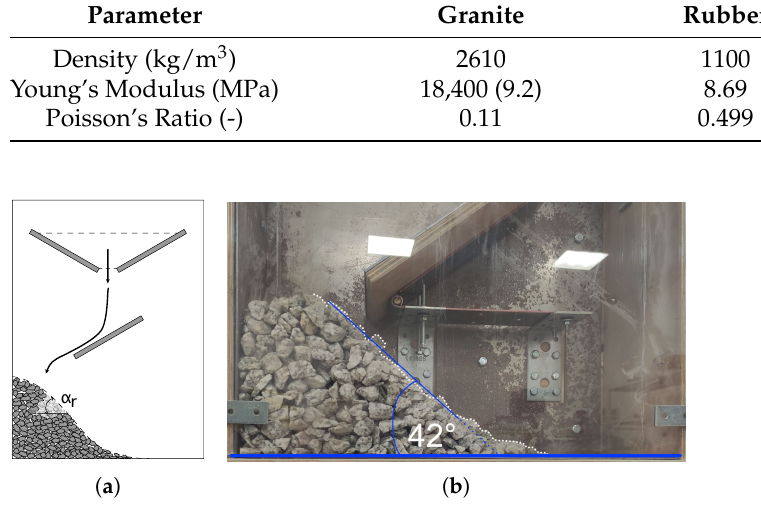
Figure 8. Calibration: ( a ) scheme of the calibration box and ( b ) granite angle of